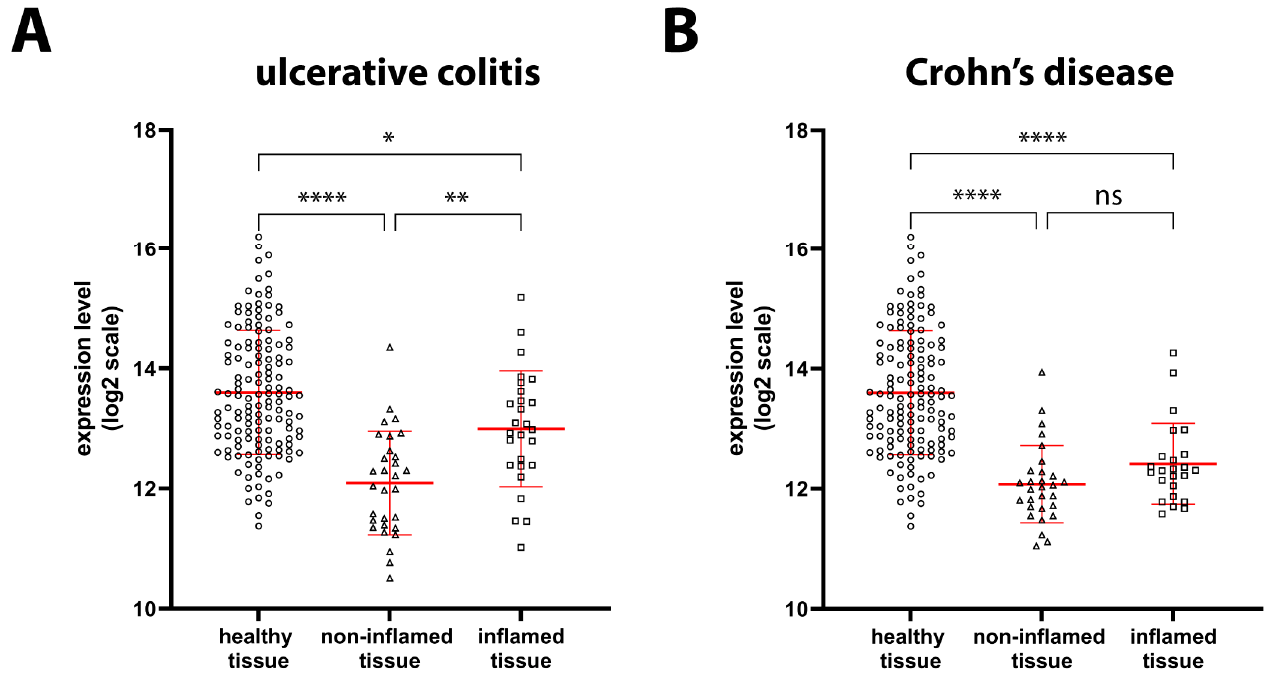
Figure 2. GILZ in healthy, UC, and CD tissues. ( A ) GILZ gene expression levels based on microarray data were compared between healthy tissue (circles, n = 142), as well as non-inflamed (triangles, n = 30) and inflamed (squares, n = 27) tissue from UC patients. ( B ) GILZ gene expression levels based on microarray data were compared between healthy tissue (circles, n = 142), as well as non-inflamed (triangles, n = 29) and inflamed (squares, n = 24) tissue from CD patients. Data are shown by using a scatter plot, with each dot representing a single patient; values are shown in log2 scale and expressed as mean ± SD. p -values <0.05 were considered statistically significant; p < 0.05 = *; p < 0.01 = **; p < 0.0001 = ****. ns =